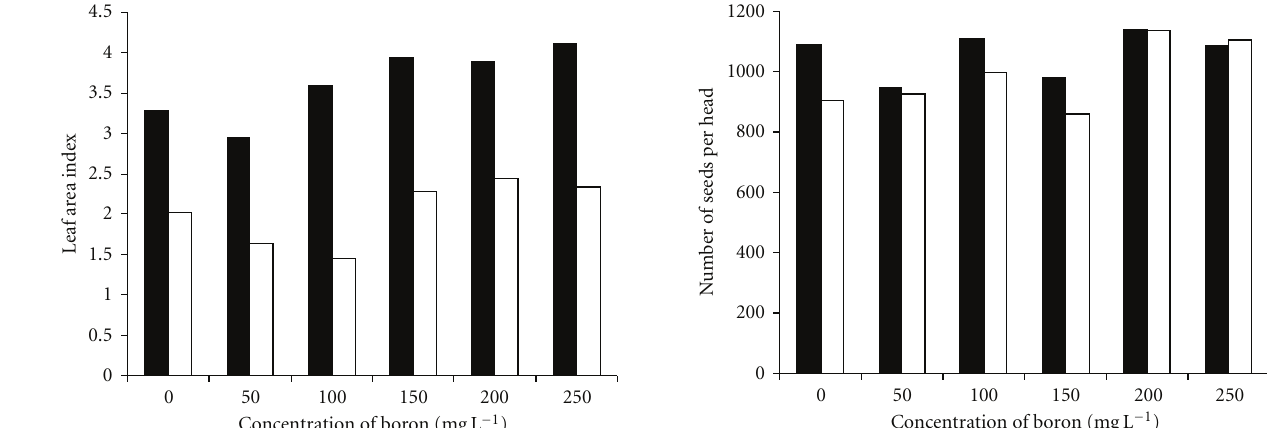
Figure 1: E ff ect of foliar applied boron on leaf area index (LAI) in spring (filled columns) and autumn (open columns) sunflower crops. (LSD 0 . 05 0.420 and 0.277, resp.).